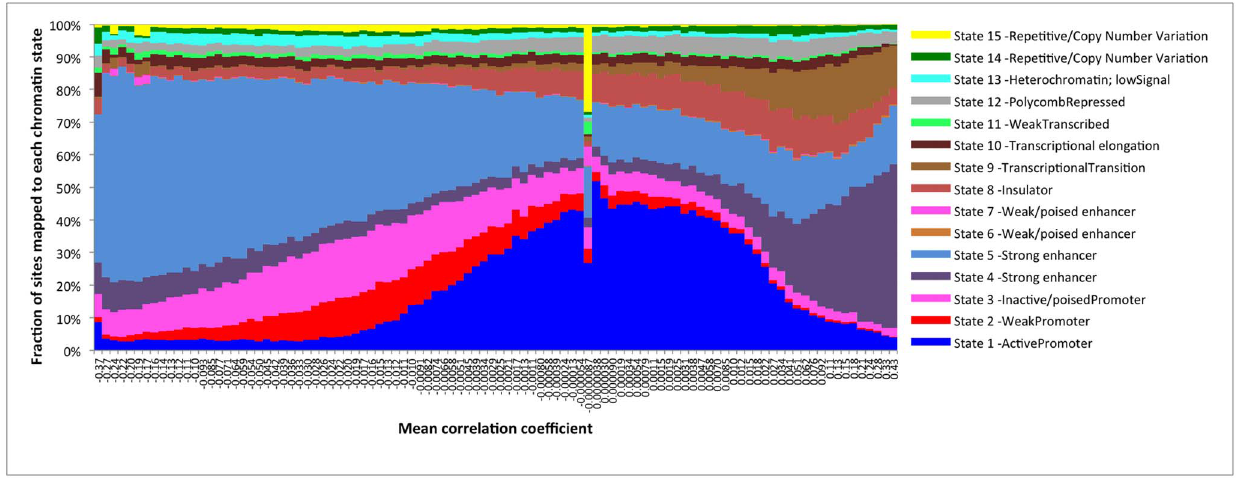
Figure 5. Distribution of DNA methylation sites mapped to regions with different chromatin states as defined by Ernst et al [ 21 ] . DNA methylation marks are ordered by the correlation coefficient with age and combined into 100 bins.